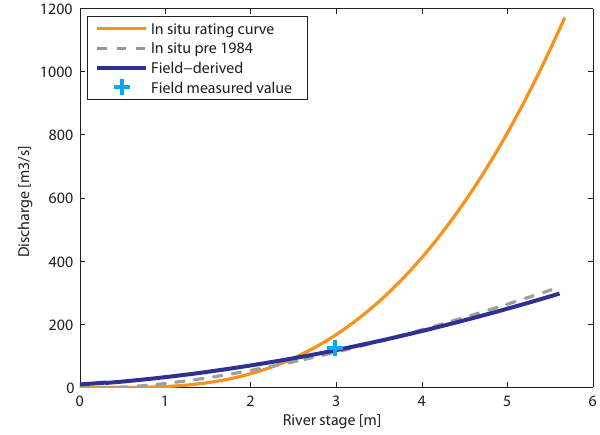
Fig. 6. In situ and field rating curves at VS